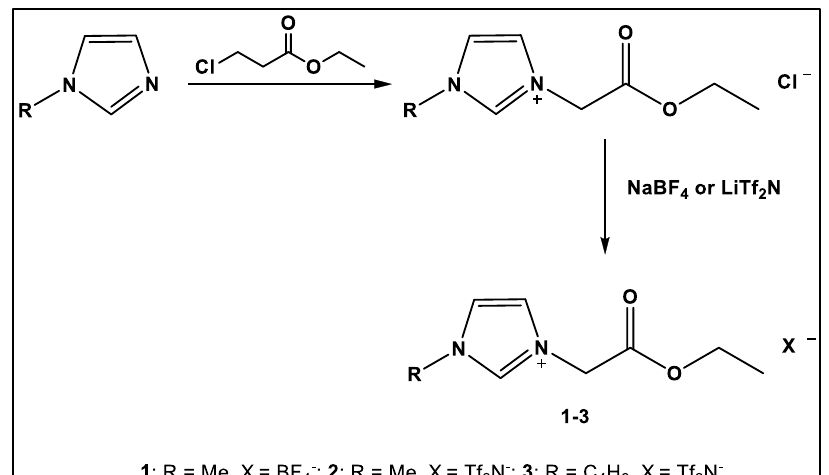
Figure 9. Synthesis of imidazolium ILs.